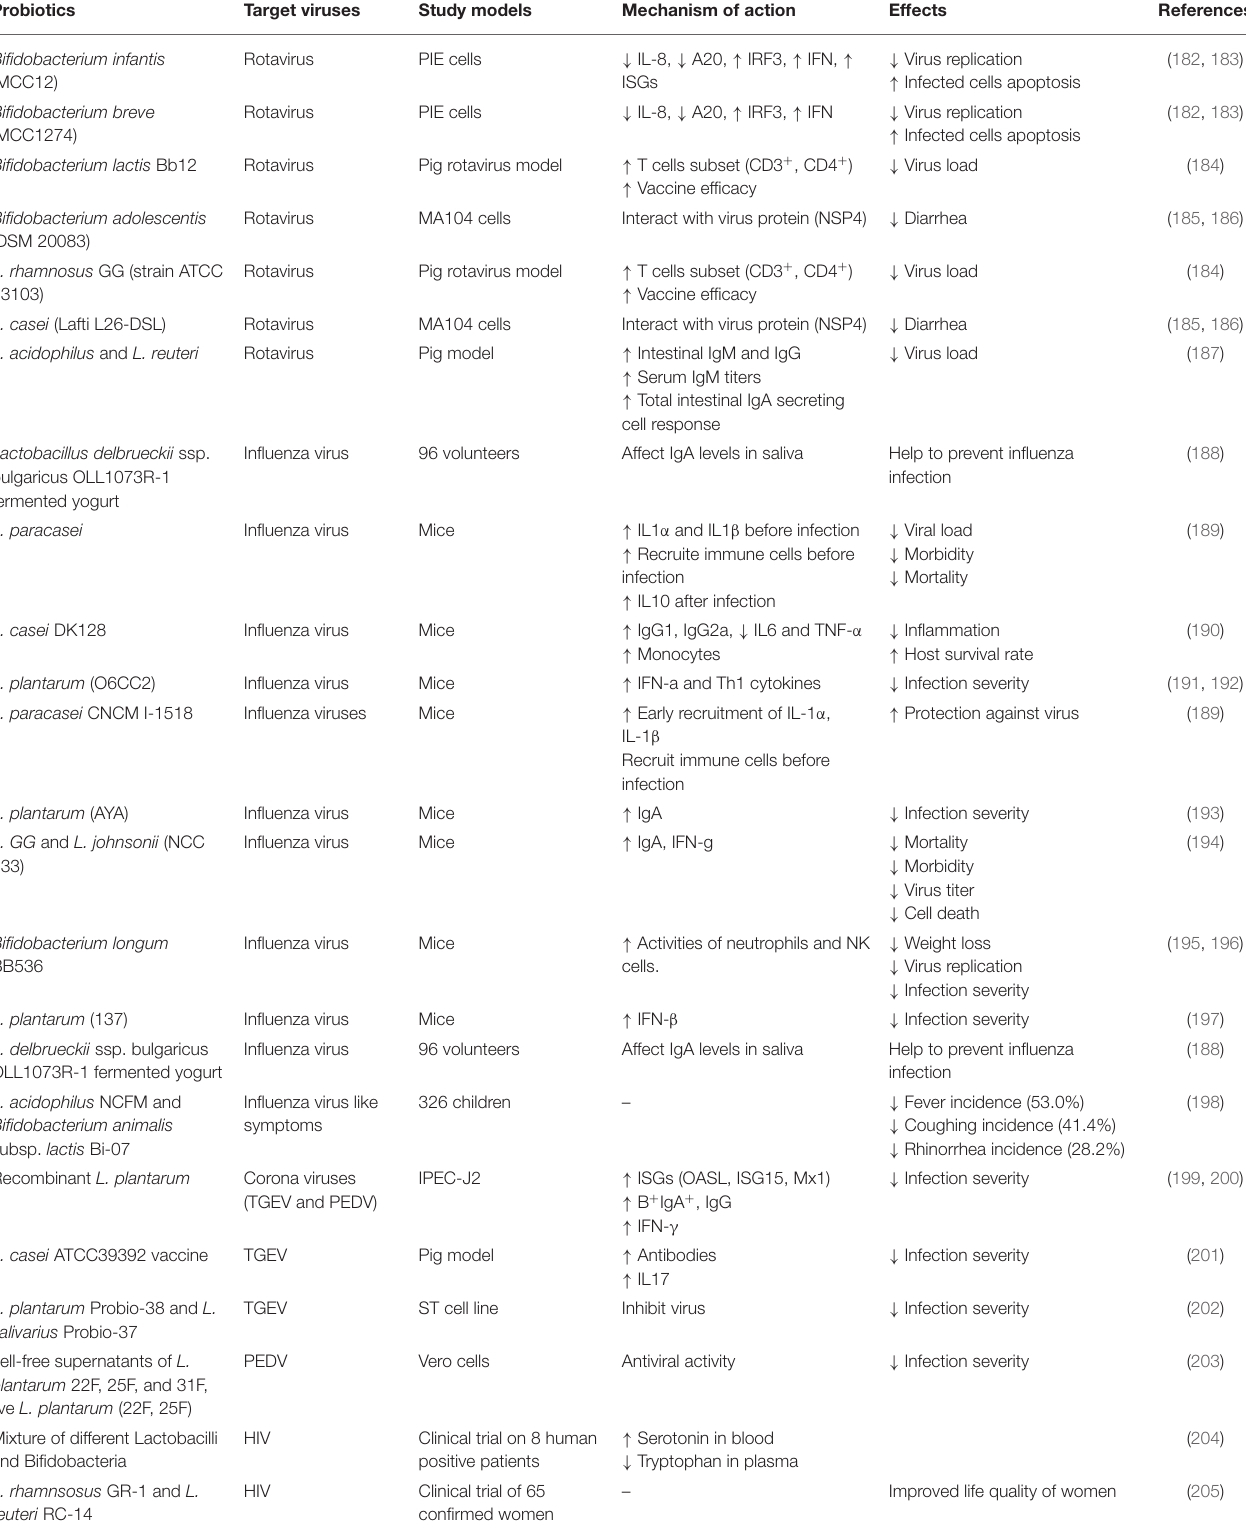
TABLE 3 | Probiotics therapies during viral